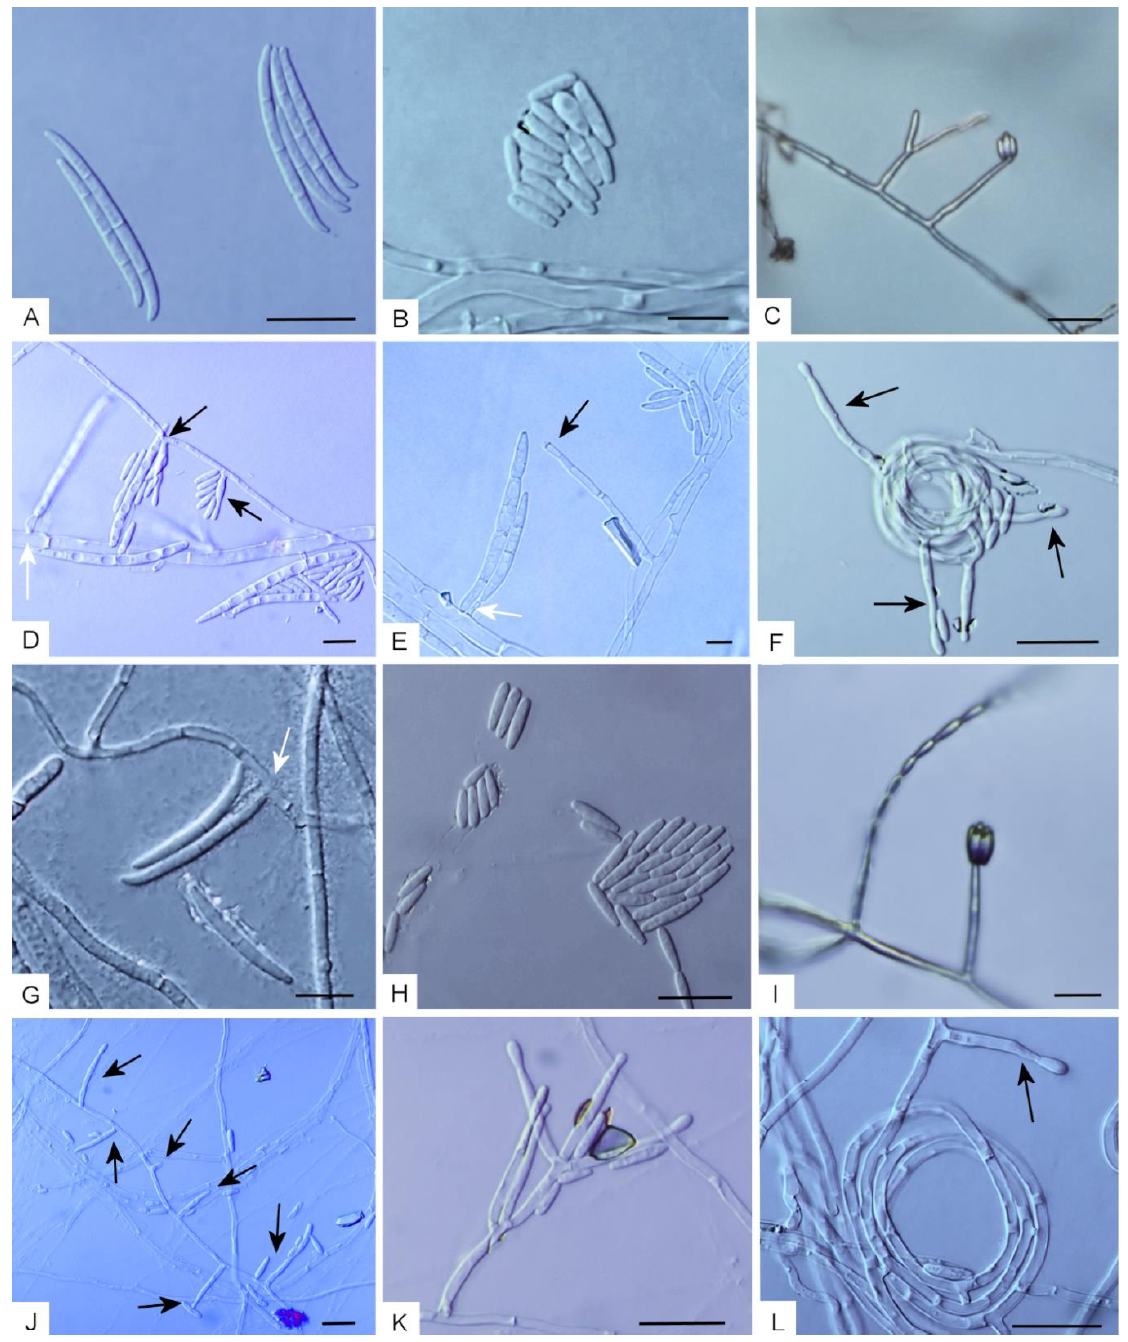
Figure 2. ( A – F ) Morphological characters of Fusarium casha on carnation leave agar (CLA) . ( A ) Macroconidia. ( B ) Microconidia. ( C ) Microconidia produced in false heads. ( D , E ) Conidiogenous cells forming micro- and macroconidia (conidiogenous cells forming macroconidia indicated in white arrows). ( F ) Substrate hyphae bearing conidiogenous cells coiling into circles. ( G – L ) Morphological characters of F. curculicola on CLA. ( G ) Macroconidia (conidiogenous cell indicated with a white arrow). ( H ) Microconidia. ( I ) Microconidia produced in a false head (right) and a chain (left). ( J ) Conidiogenous cells (arrows). ( K ) A conidiophore. ( L ) Hyphae bearing a conidiogenous cell coiling into circles. Bars: 10 µm.